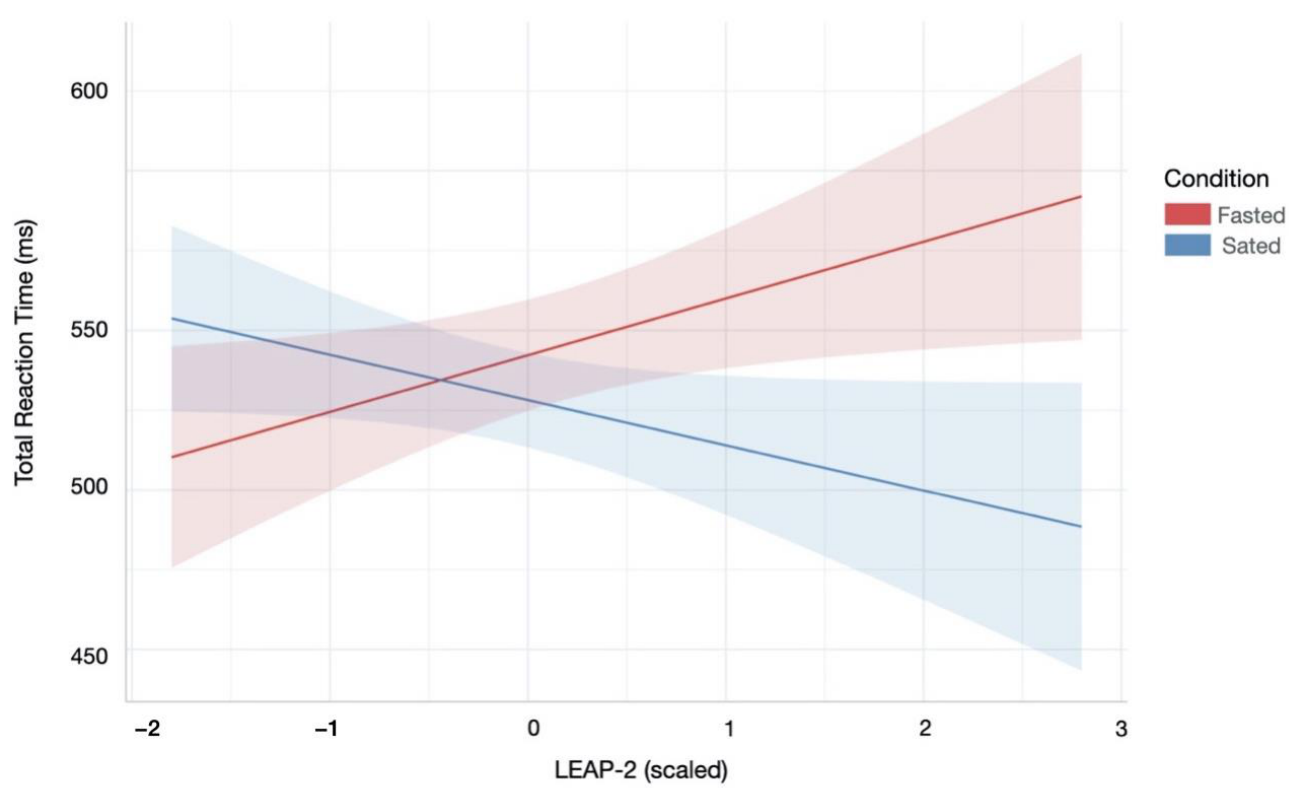
Figure 5. Relationship between reaction time during attentional control and LEAP-2 across hunger and satiety. Lower LEAP-2 levels during the sated condition were associated with slower reaction times overall. There were similar patterns for reaction times during correct and incorrect responses (not shown). Red/blue coloured area indicates 95% confidence interval of linear model’s predictions.